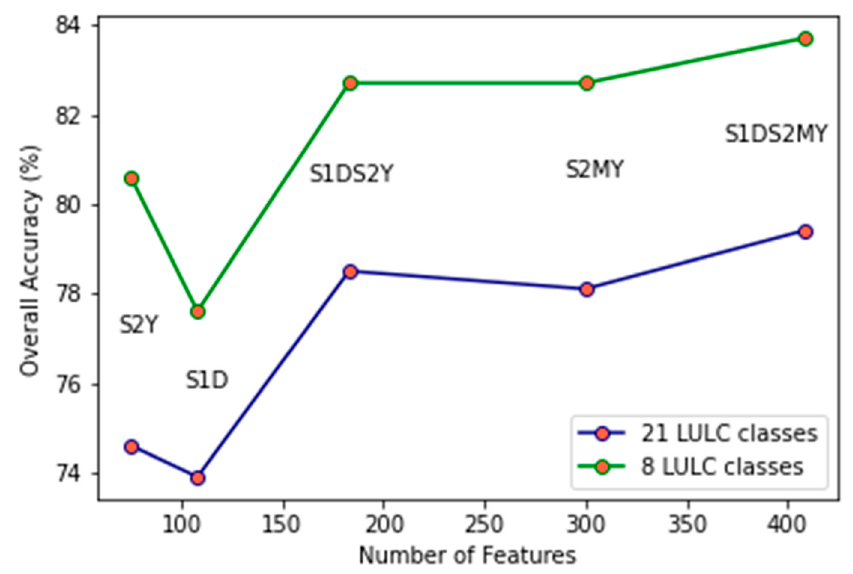
Figure 2. The relation of overall accuracy with the number of features in five different feature sets using 21 and 8 LULC